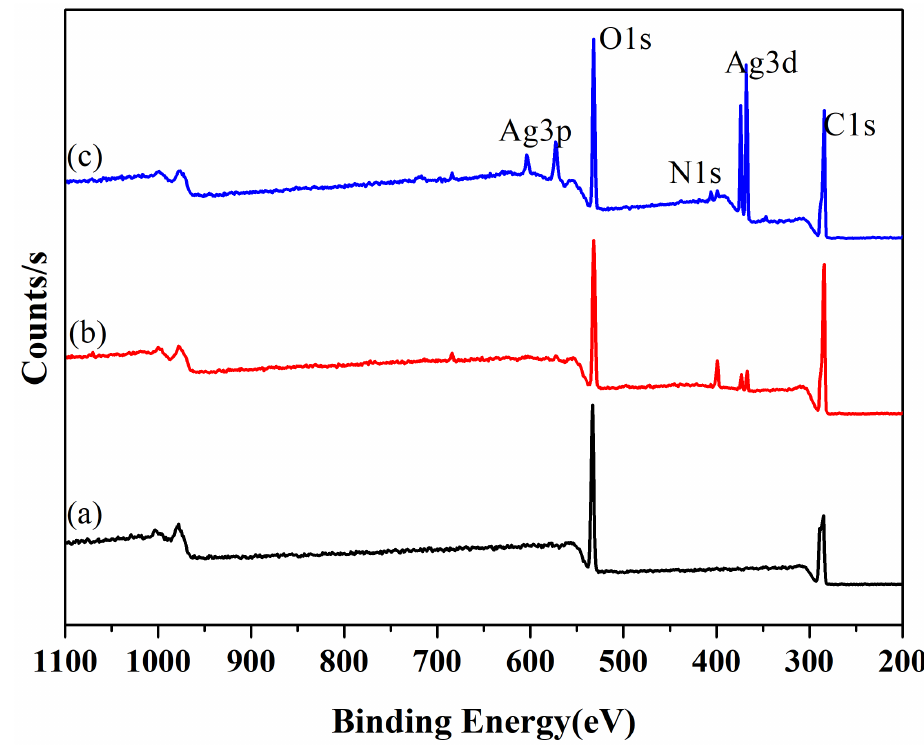
Figure 6. XPS survey scan of PLA nonwoven fabrics: ( a ) control; ( b ) CS-Ag NPs treated; ( c ) DBD- CS-Ag NPs treated.